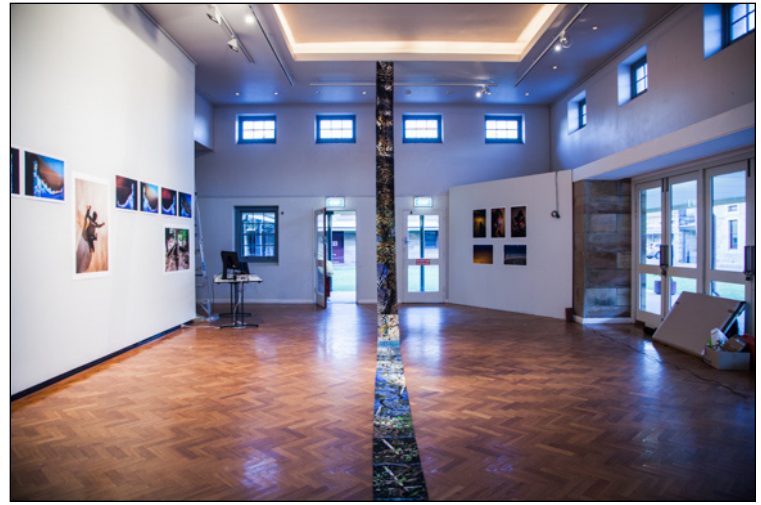
Figure 4. The Keeling (Over) Curve (years dot ‐ thru ‐ dash) ( centre ) in Facing Futures Free From Fear (2013).